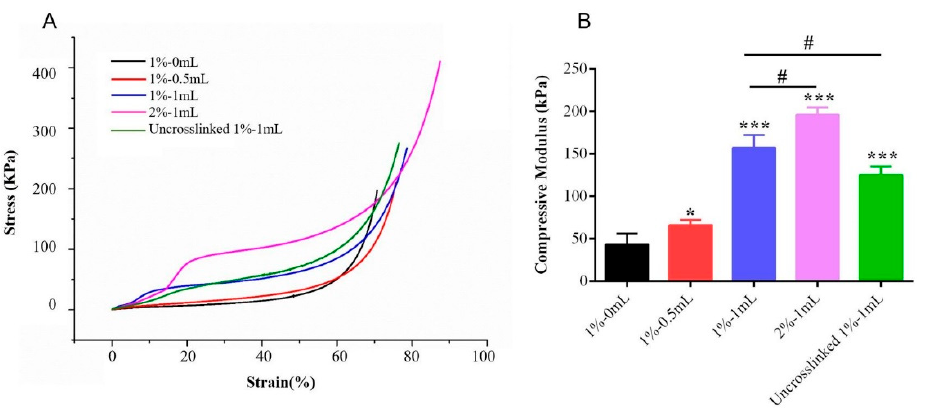
Figure 4. Mechanical tests of the different scaffolds. ( A ) Stress–strain curves of the scaffolds; ( B ) compression modulus of 3D nanofibrous scaffolds. * p < 0.05 and *** p < 0.001, compared with pure chitosan/RHC scaffold (1%-0 mL), # p < 0.05. Bars represent mean ± SD, number of repeats n = 5.